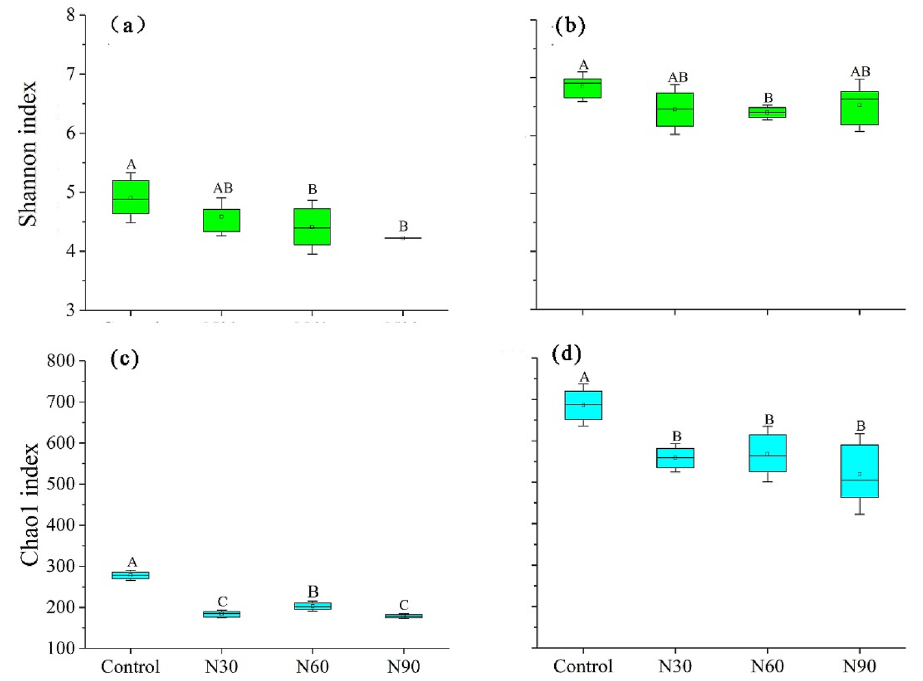
Figure 3. Shannon and Chao1 indexes for methanotrophs ( a , c ) and methanogens ( b , d ) under different N addition treatments. Different letters indicate significant differences ( P < 0.05) between treatments.